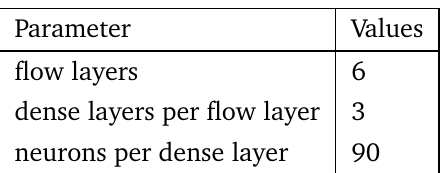
Table 10: Planar model